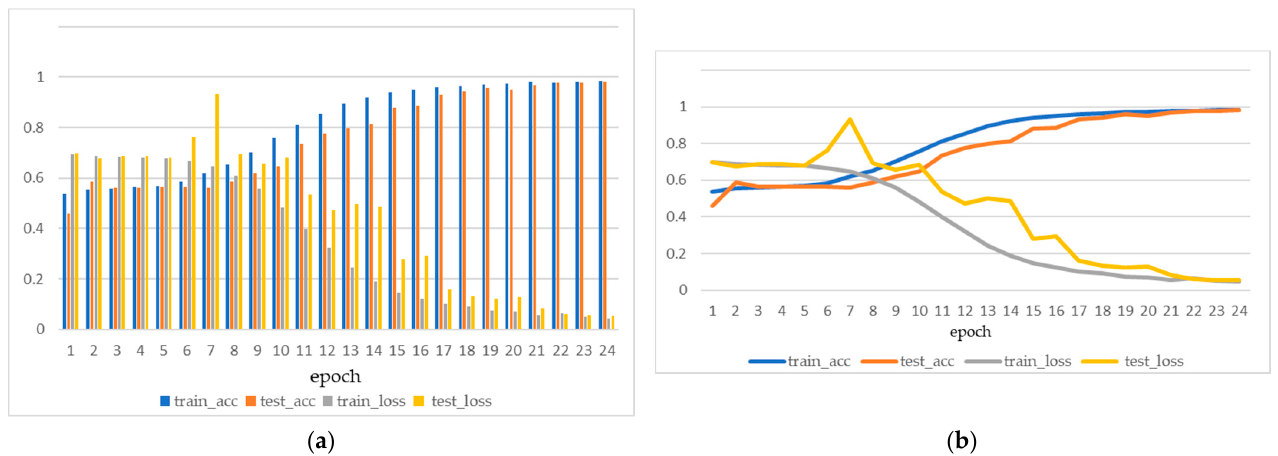
Figure 11. Model accuracy and loss curves during the first 25 epochs. ( a ) histogram, ( b ) line chart. Table 3. Comparison with other studies that used the DEAP